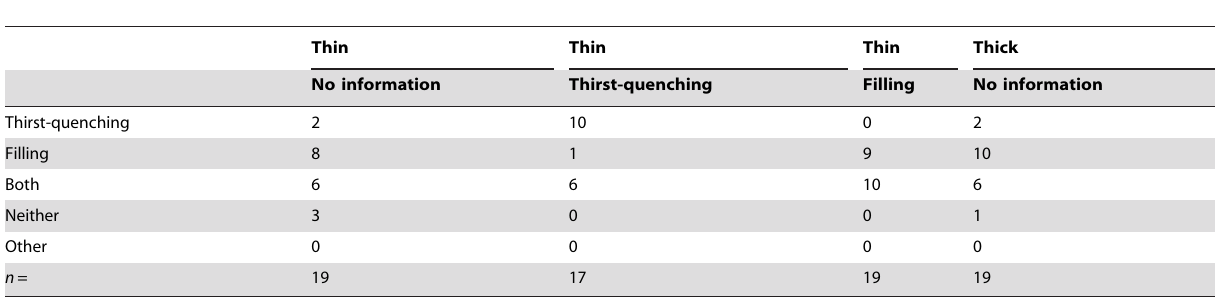
Table 4. The reported expectations of the test drinks, recorded during the debrief session.